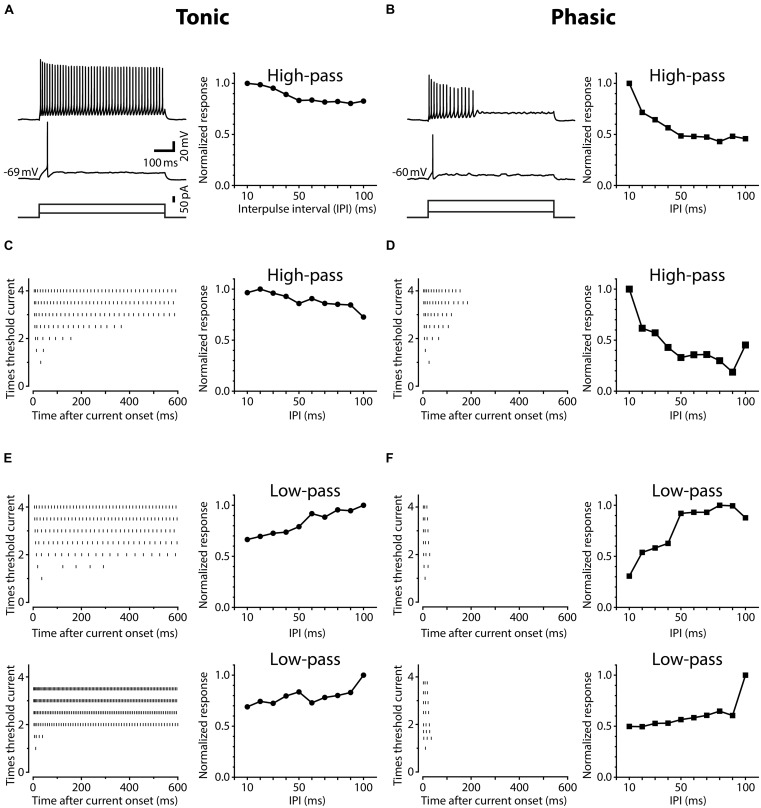
Neurons in the posterior exterolateral nucleus (ELp) exhibit two distinct firing patterns. (A) Left, spiking responses of a weakly adapting (tonic) ELp neuron to current steps of 600 ms duration (bottom) at threshold (middle) and three-times threshold (top) current intensities. Right, high-pass tuning curve obtained from the same neuron. The plot shows the average maximum amplitude of individual postsynaptic potentials (PSPs) in response to bipolar stimulation of the anterior exterorateral nucleus (ELa) at interpulse intervals (IPIs) ranging from 10 to 100 ms. The amplitude is further normalized by the largest maximum depolarization across IPIs. See Section “Materials and Methods” for details. Scale bars also apply to (B). (B) Spiking response of a strongly adapting (phasic) neuron (left) that exhibited high-pass tuning to ELa stimulation (right). (C–F) Examples of three additional tonic (C,E) and three additional phasic (D,F) neurons that showed high-pass (C,D) or low-pass (E,F) responses. Left: Raster plots show the times of action potential peaks during current injection (abscissa) at different current amplitudes, which were normalized to the threshold intensity (ordinate).